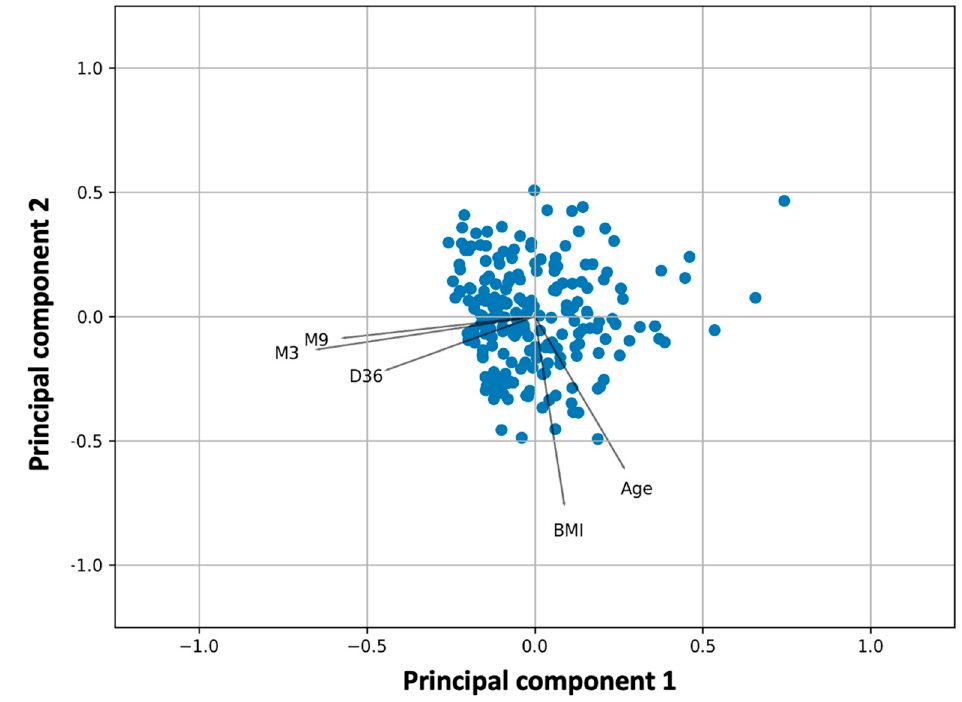
Figure A2. Principal component analysis of percent inhibition of SARS-CoV-2 binding at day 36 and at the third and ninth months after vaccination. The coordinates of the two-dimensional plot refer to the “scores” of the variables in the dimensionality reduced space (two principal components are shown). Key : D36, neutralizing antibody levels two weeks after second vaccination; M3 neutralizing antibody levels three months after second vaccination; M9, neutralizing antibody levels nine months after second vaccination; BMI, body mass index.